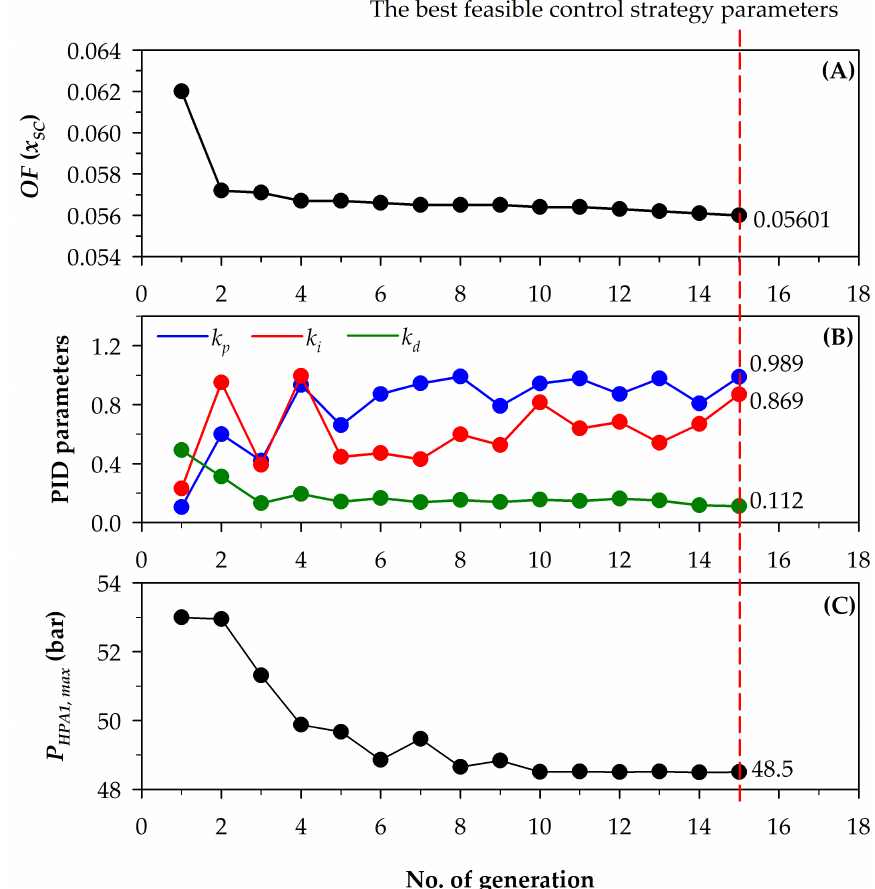
Figure 11. Chronological variation of the best value obtained in each generation for ( A ) objective function, ( B ) PID controller, and ( C ) P HPA 1, max